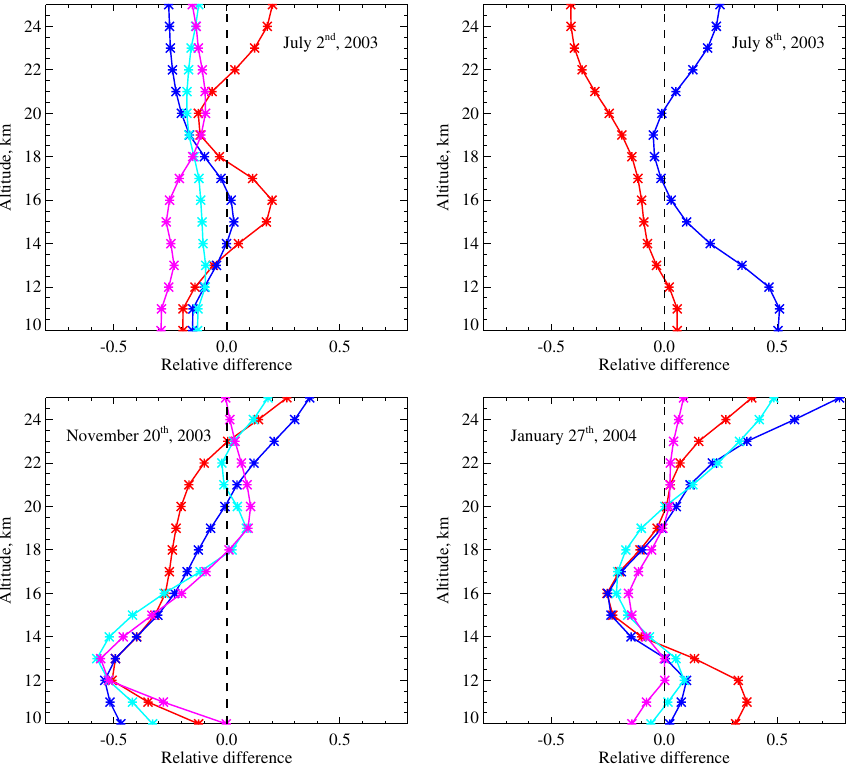
Fig. 18. Same as Fig. 17 but for relative